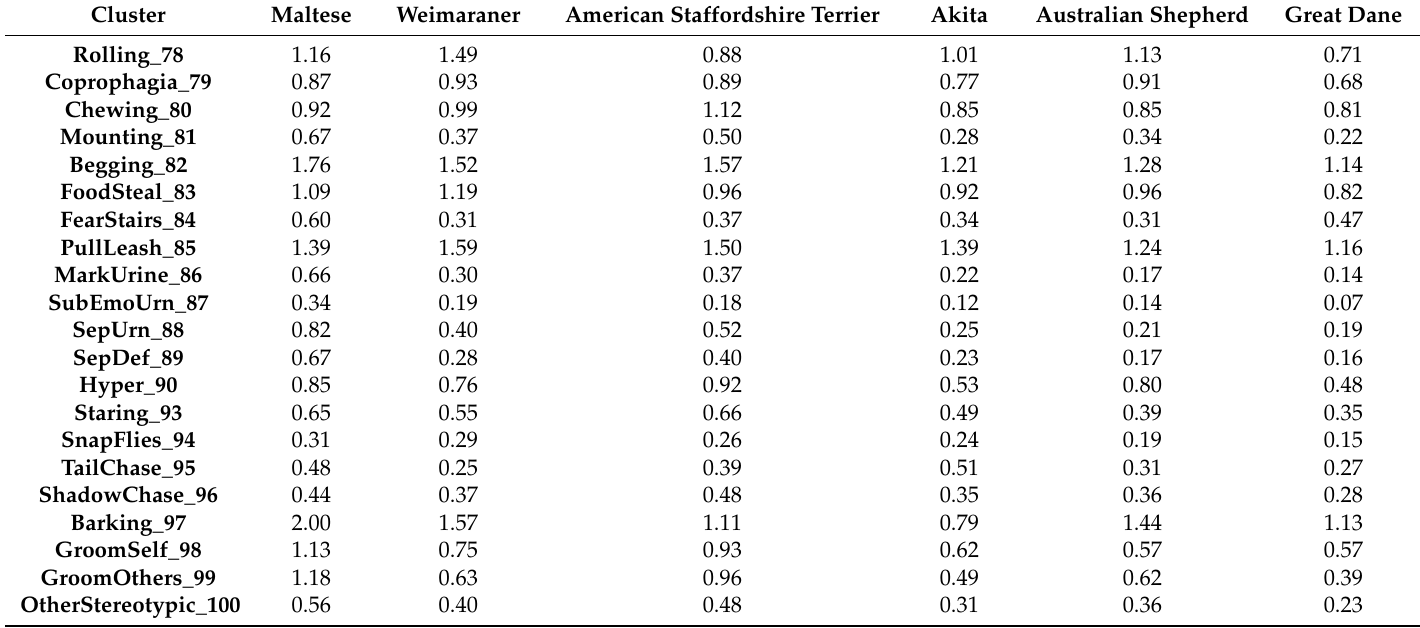
Table 5. Cluster average C-BARQ scores for miscellaneous behaviours (ordered from left to right by median cluster height).